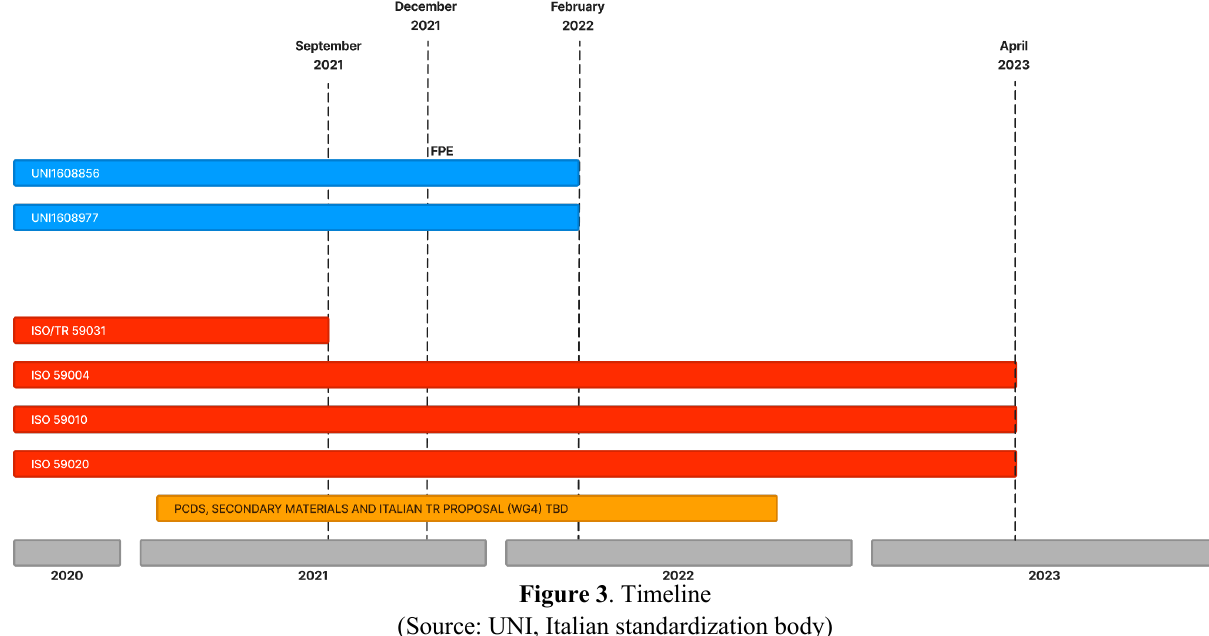
Figure 3 . Timeline (Source: UNI, Italian standardization